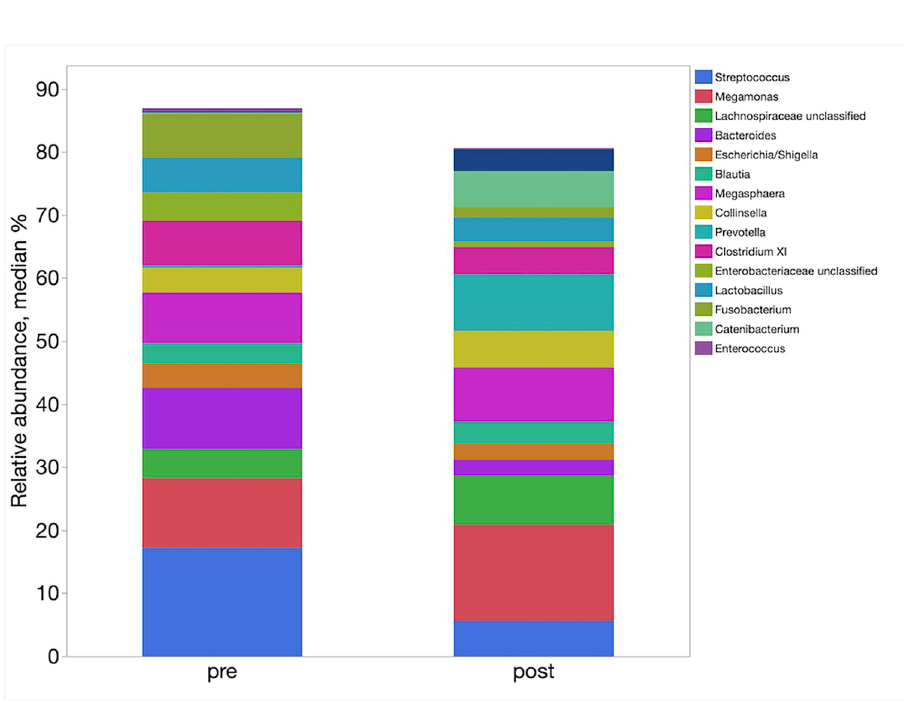
Fig 8. Relative abundances of the main bacterial genera enriched between the pre and one-week post FMT samples.